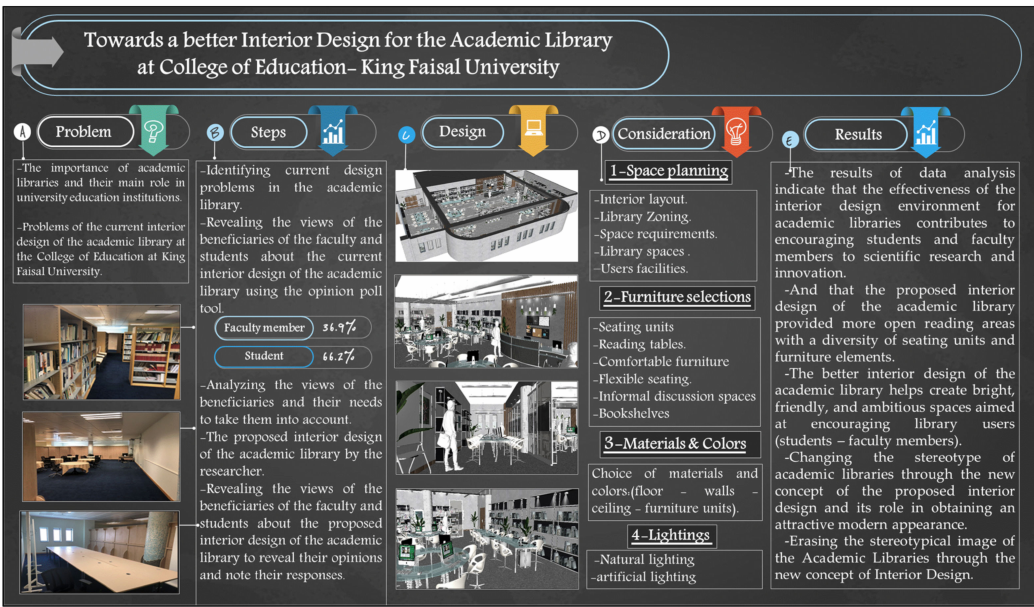
Figure 26. The framework explains the steps of the